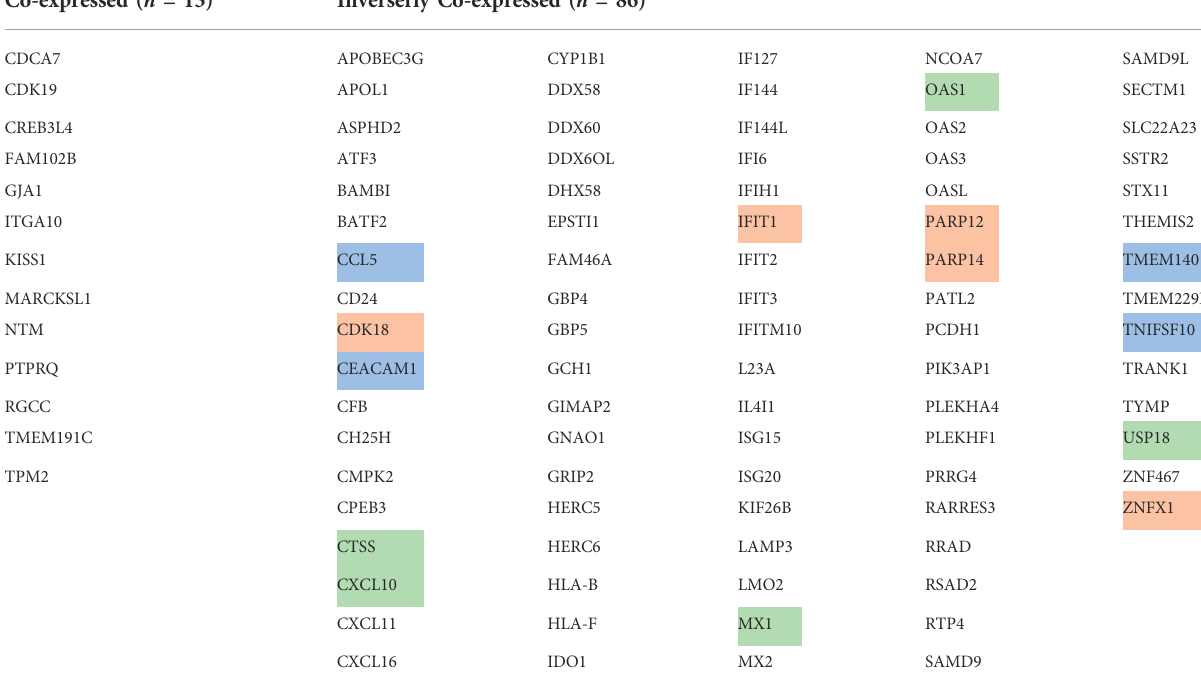
TABLE 1 RNAseq data showing the thirteen genes that are elevated in expression (co-expressed) in normal human foreskin fi broblasts (HFF) and MDAMB-231 cells expressing Tpm2.1. In the HFF cells after Tpm2.1 knockdown and the MDA-MB-231 cells, there were 86 genes that were elevated in expression (inversely